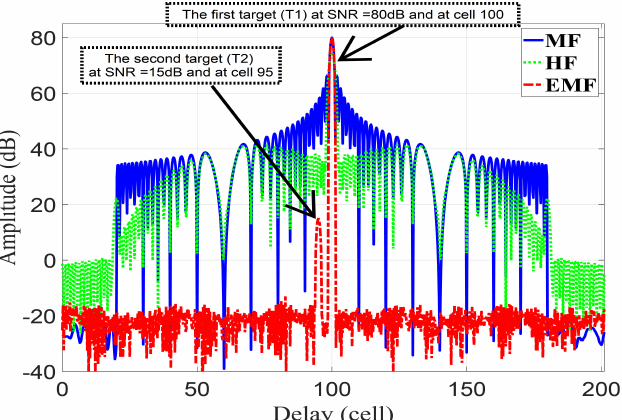
Figure 15. The amplitude response of the proposed EMF, MF, and